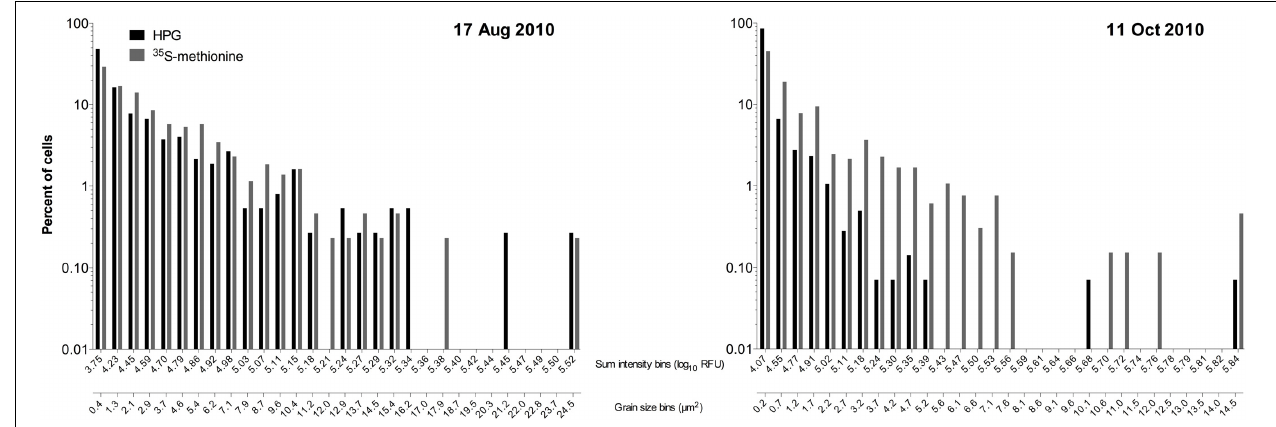
FIGURE 6 | Distributions of individual cell signal intensities for click chemistry (HPG) and micro radiography ( 35 S-methionine) determined via parallel incubations (i.e., separate 2mL samples from the same flask) on two sample dates at Scripps Pier.